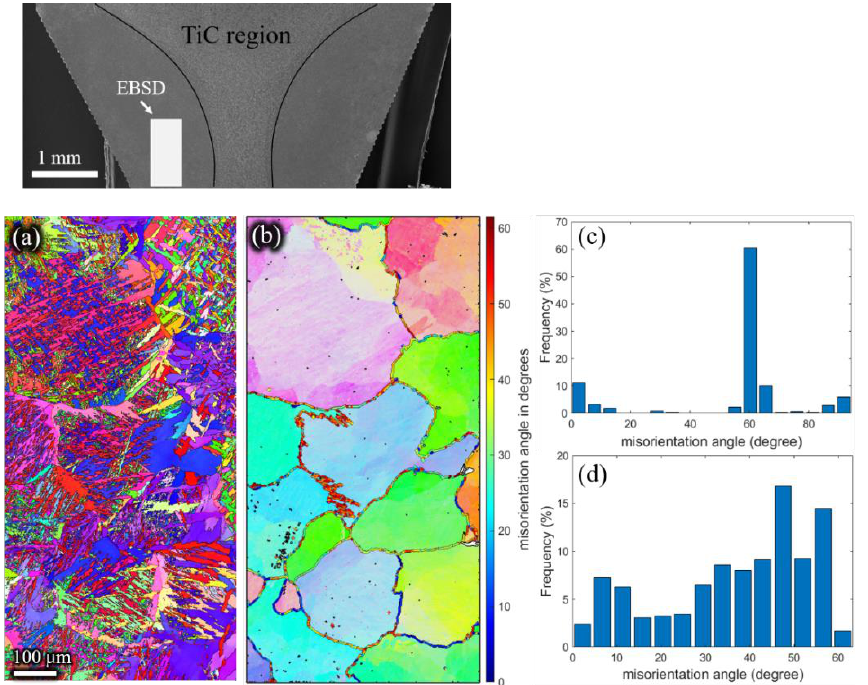
Figure 11. Inverse pole Figures of ( a ) the α phase, and ( b ) the reconstructed β phase. Misorientation angle of ( c ) α grains, and ( d ) reconstructed β grains of the residual deformed billet with a holding time of 5 s.